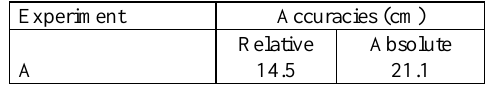
Table 1. Relative and absolute accuracy obtained with proposed method